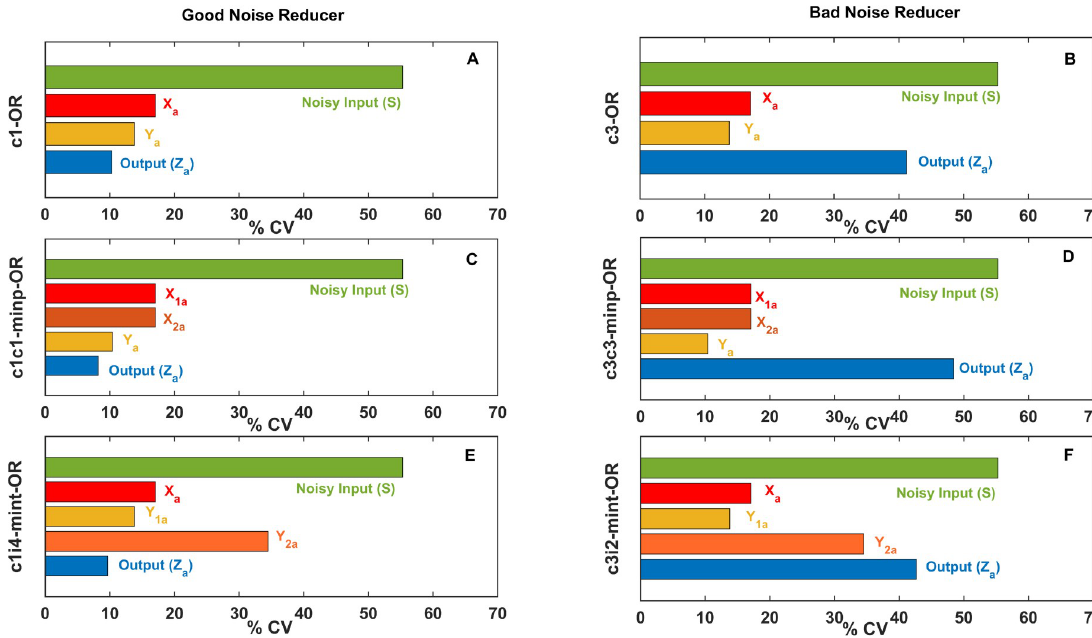
Fig 7. Noise reduction at each layers of best and worst performing FFLs. Coefficient of variations (% CV) of each species of best noise reducing (A, C, E)and worst noise reducing (B, D, F) FFLs of different types are plotted for mean input level = 6. Simple FFLs: c1-OR (A), c3-OR (B), multi-input FFLs: c1c1-minp-OR (C), c3c3-minp-OR (D) and multi-intermediate FFLs: c1i4-mint-OR (E), c3i2-mint-OR (subplot F) were investigated here.